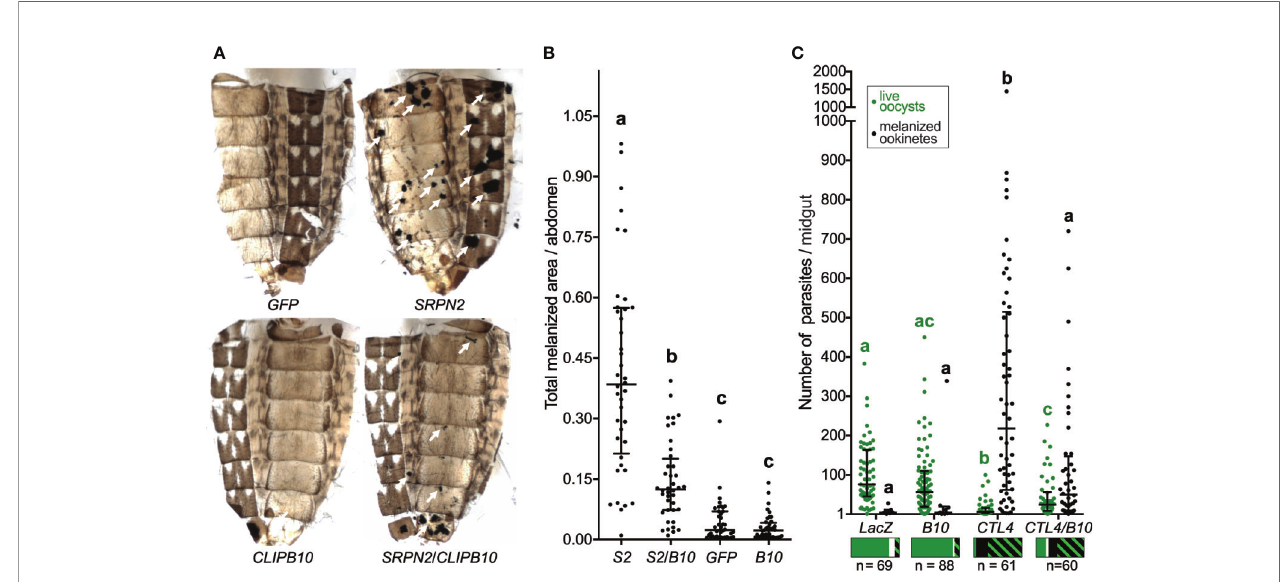
FIGURE 1 | CLIPB10 knockdown partially reverts ds SRPN2 - and ds CTL4 -induced phenotypes. (A) Abdominal images were collected 21 days post dsRNA injection. Melanotic tumors are indicated by white arrows. (B) Total melanotic areas per abdomen (arbitrary unit) were quanti fi ed by Image J. Median and interquartile range are marked (n = 40). Kruskal-Wallis test followed by Dunn ’ s multiple comparison test were performed to calculate statistical signi fi cance. Medians with a common letter are not signi fi cantly different ( P > 0.05). (C) Live GFP-expressing oocysts (green circles) and melanized ookinetes (black circles) per gut were scored. Median and interquartile range are marked (n, number of guts examined per treatment group). Both oocyst and melanized ookinete infection intensities, respectively were statistically signi fi cantly different between all treatment groups (Kruskal-Wallis test P < 0.0001). Medians with a common letter are not signi fi cantly different (Dunn ’ s multiple comparison test, P > 0.05), with letters in green indicating live oocyst comparisons, and letters in black indicating melanized ookinetes (see Table S3 for complete summary statistics). The bar charts below each treatment group show prevalence as the fraction of guts containing live oocysts only (green), melanized ookinetes only (black), both live oocysts and melanized ookinetes (green/black hatch), and no parasites (white). The statistical analyses of the prevalence data are summarized in Table S4